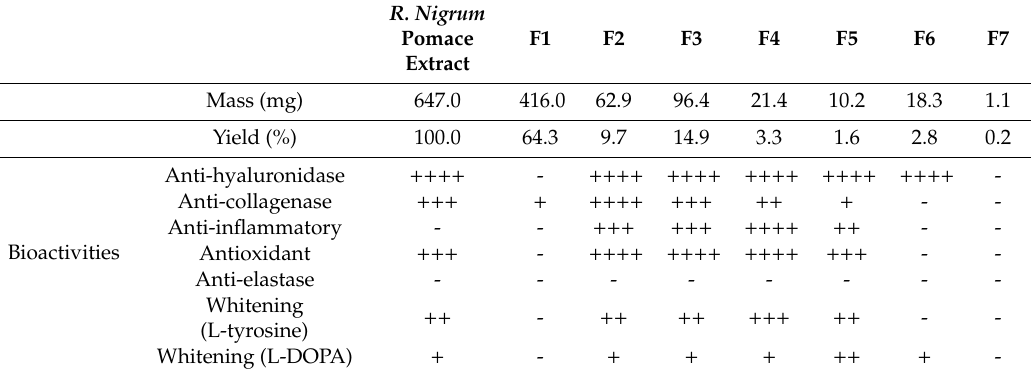
Table 2. Bioactivities of R. nigrum pomace extract and of the corresponding fractions F1–F7.